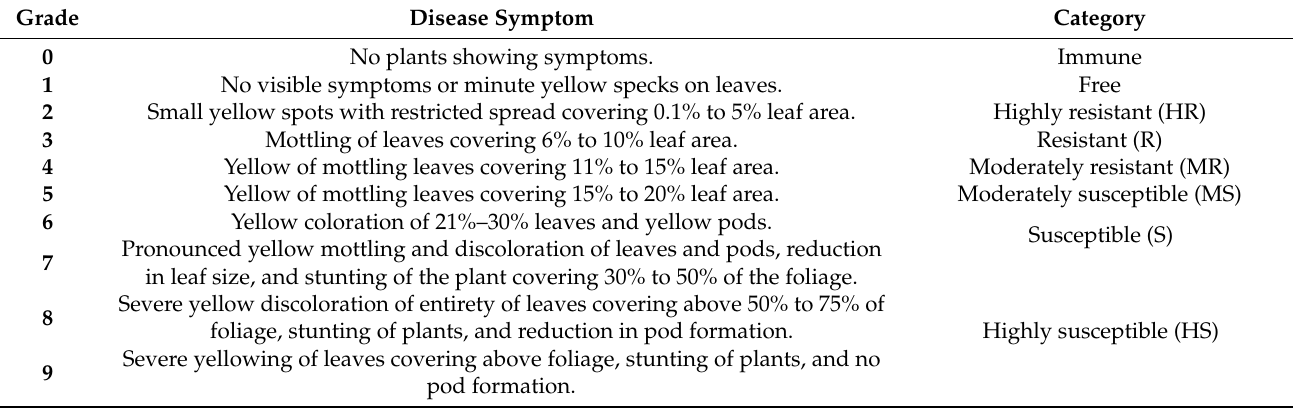
Table 1. Details of YMV screening